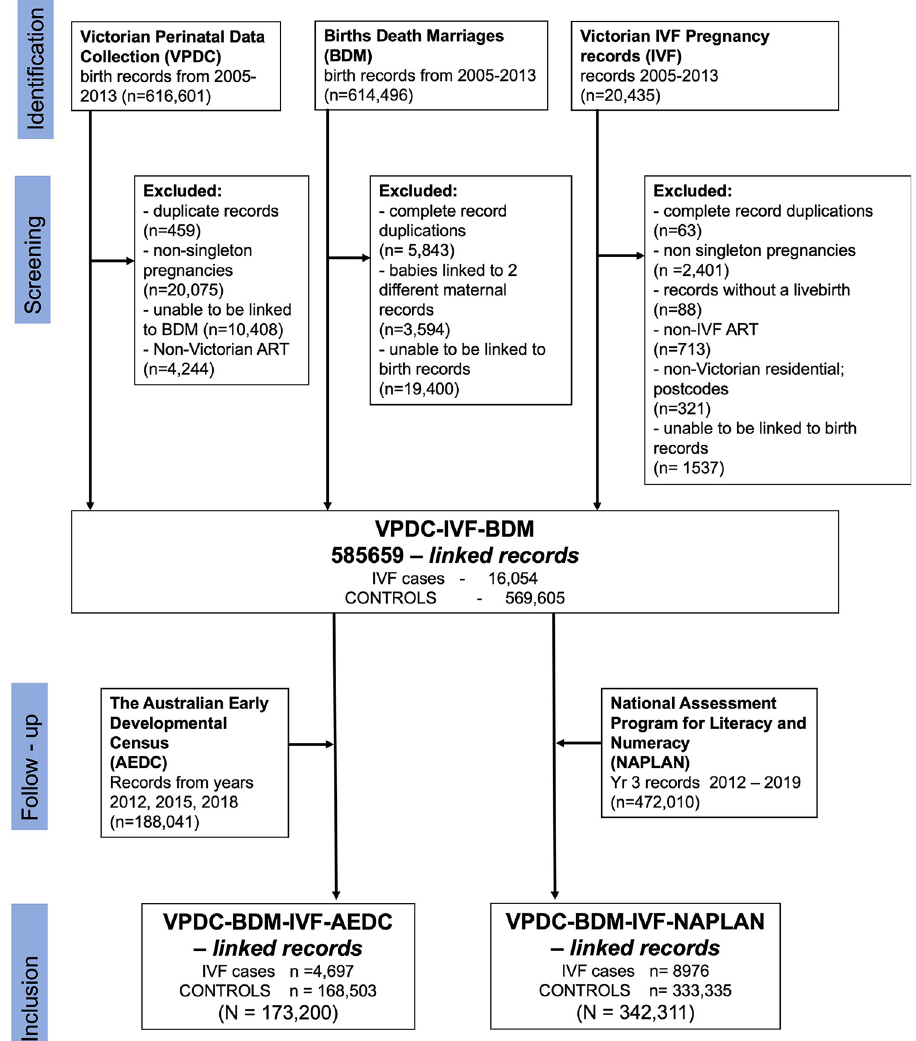
Fig 1. Participant flow chart. IVF, in vitro fertilisation; IVF cases, pregnancies and children identified with conception assisted by IVF; Controls, pregnancies and children not identified as IVF assisted conception; ART, assisted reproductive technology; non-IVF ART, ovulation induction and intrauterine insemination; VPDC, Victorian Perinatal Data Collection; BDM, Victorian Births Death Marriages Registry; IVF, combined Victorian IVF pregnancy record